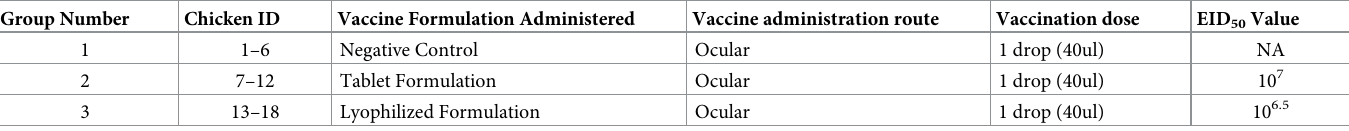
Table 3. In-vivo (safety) trial- group (chickens), vaccine administration mode and dose with EID 50 values. Group Number Chicken